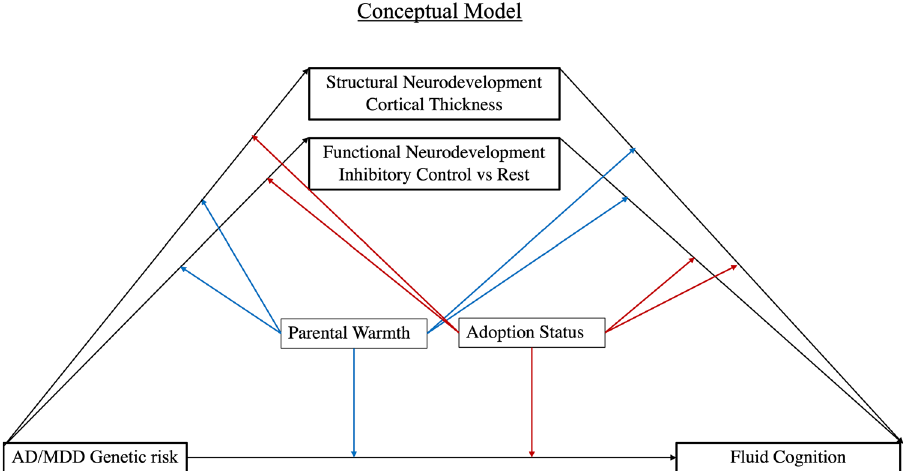
Figure 1. Outline of our conceptual model. Genetic risk for AD and/or MDD was predicted to accelerate structural and functional neurodevelopment, as reflected in patterns of cortical thickness and BOLD fMRI signal values during rest and performance of an inhibitory control task, respectively (see “Method” for details). Accelerated structural and/or functional neurodevelopment was expected to be linked to poorer fluid cognition scores. Adoption status and parental warmth were tested as potential moderators of the genetic risk-neurodevelopment-fluid cognition inter-relationships. AD Alzheimer’s Disease, MDD Major Depressive